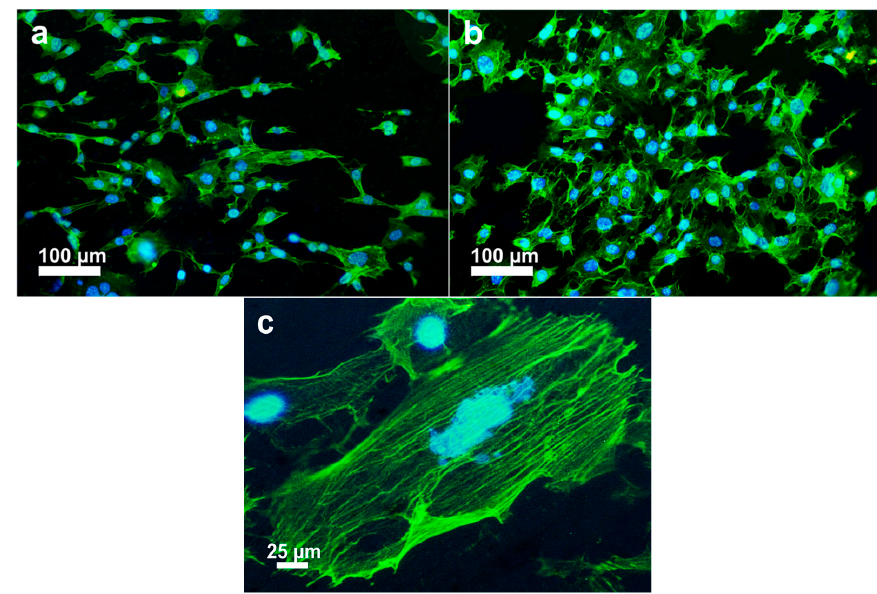
Figure 7. Fluorescence micrographs of osteoblasts cultured on PEEK/(15% nHA)-(0.93% MWNT) hybrid and stained for F-actin cytoskeleton (green) and nucleus (blue) for ( a ) 1 day and ( b ) 3 days; ( c ) High magnification image showing the morphology of well-organized actin filaments of a cell at day 3.